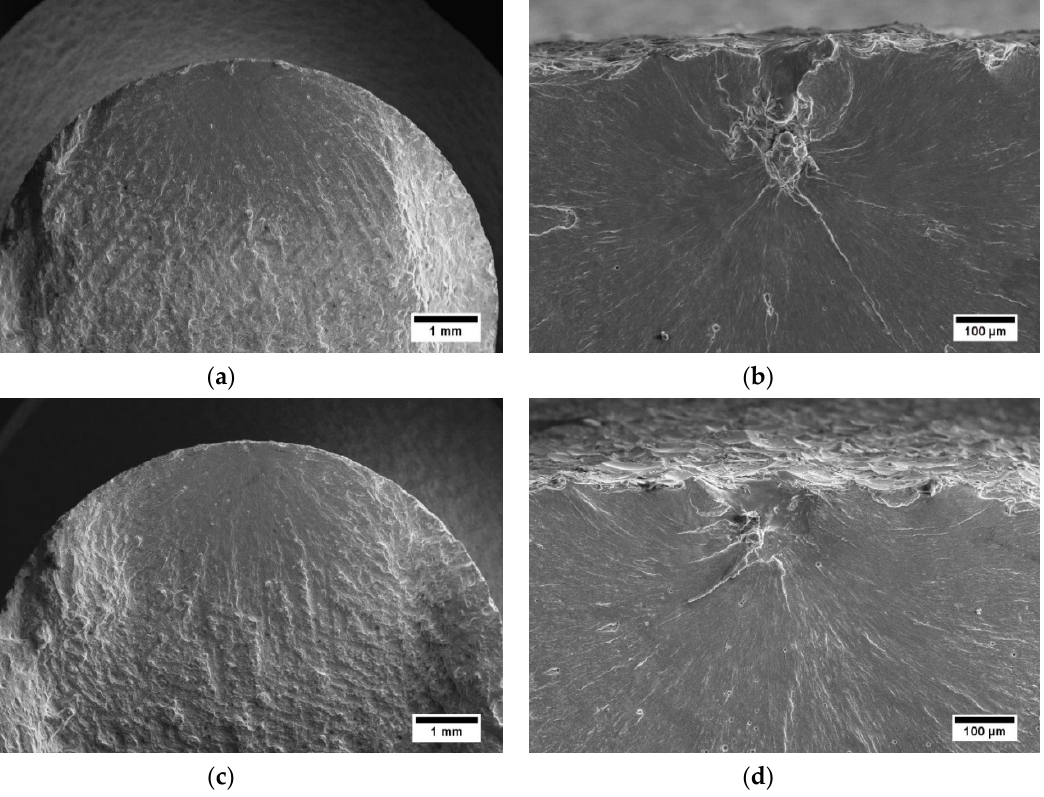
Figure 14. Fracture surfaces of SB samples failed at maximum stress level of 175 MPa; ( a , b ) the specimen failed by crack nucleation from a subsurface defect; ( c , d ) the specimen failed by crack nucleation from a surface defect.